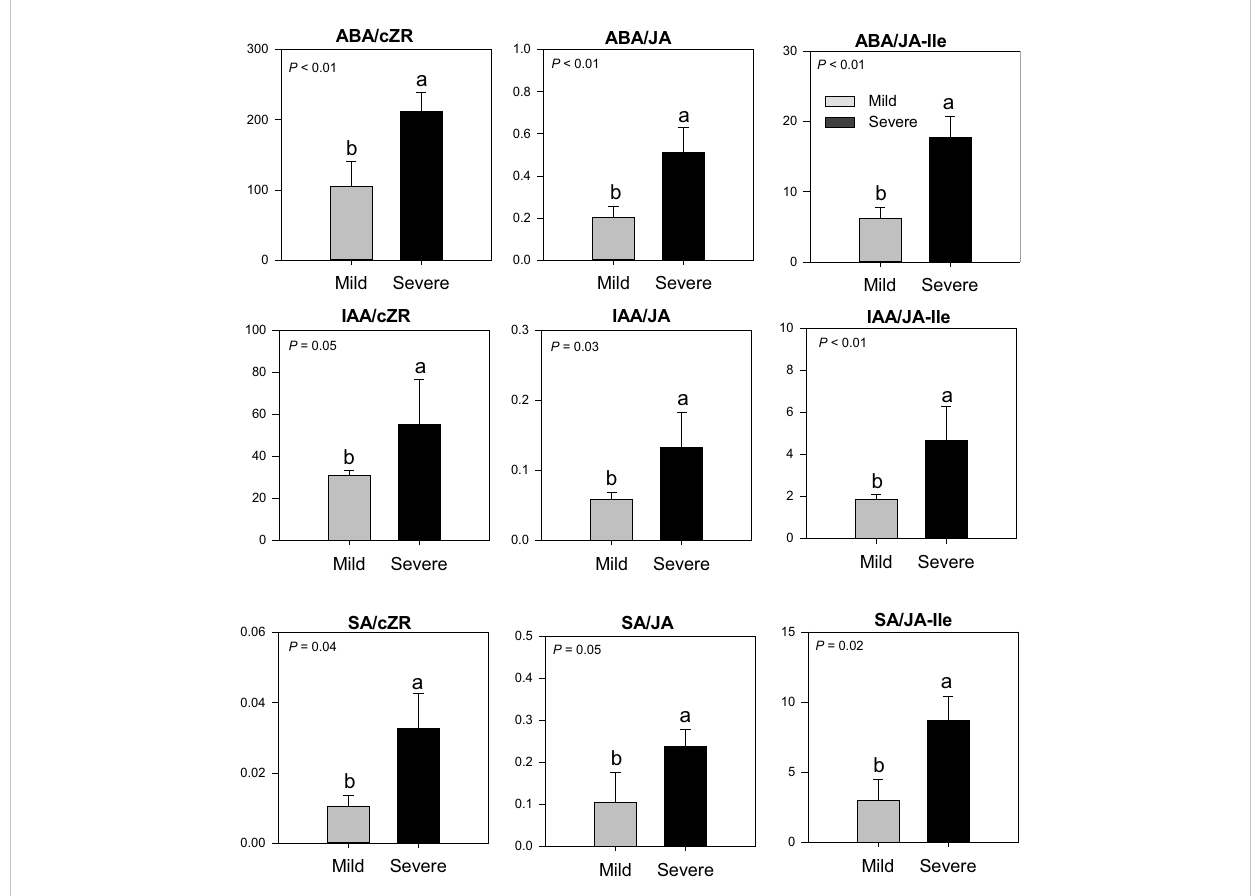
FIGURE 3 Phytohormones ratios (ABA, IAA, JA, JA/Ile, SA, and cZR) in buds of Huanglongbing (HLB)-affected ‘ Hamlin ’ trees. Data are presented as means ± standard deviation (n=4). Different letters marked on bars indicate signi fi cant differences among severe and mild trees. Grey and black colors represent mild and severe trees, respectively. ABA, abscisic acid; JA, jasmonic acid; JA-Ile, jasmonic acid iso leucine; IAA, auxins; SA, salicylic acid; cZR,